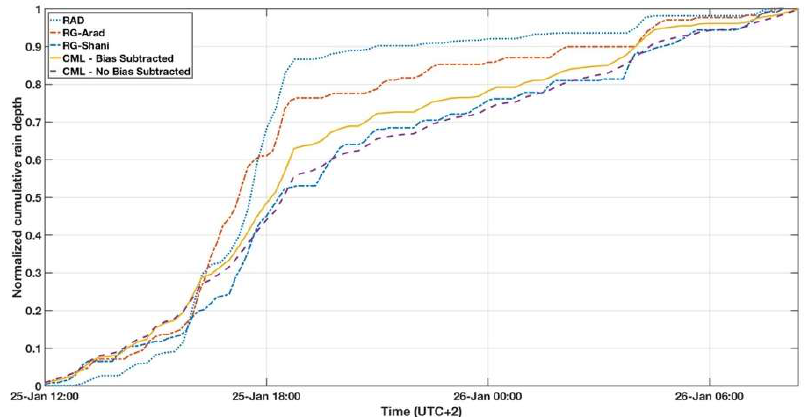
Figure 2. Normalized accumulated rain depth for a chosen event—6 November 2015 (event 1), monitored by: radar (RAD), Arad rain gauge (RG), and CML, with and without bias subtraction.